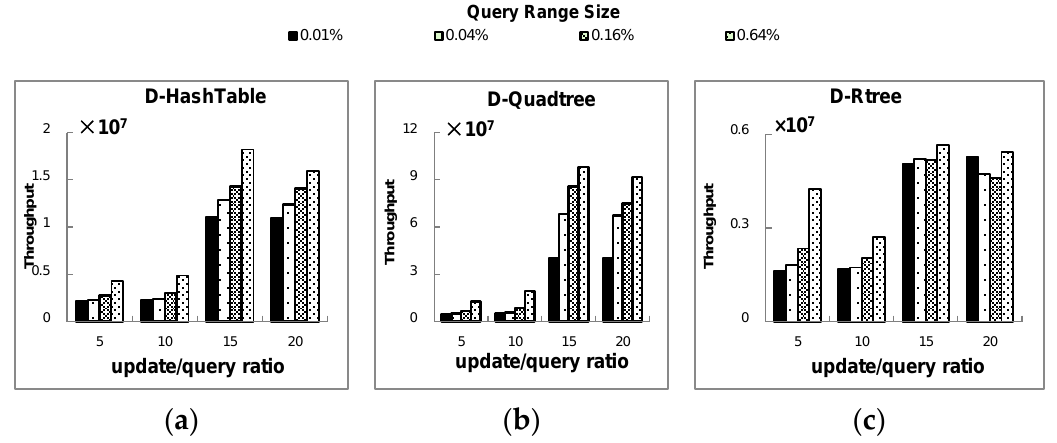
Figure 11. Effects of different query range sizes for various query ratios under a mixed workload. The search area is accessed in a spatially random manner. ( a ) Update and query throughput of D-Hahtable; ( b ) update and query throughput of D-Quadtree; ( c ) update and query throughput of D-Rtree.